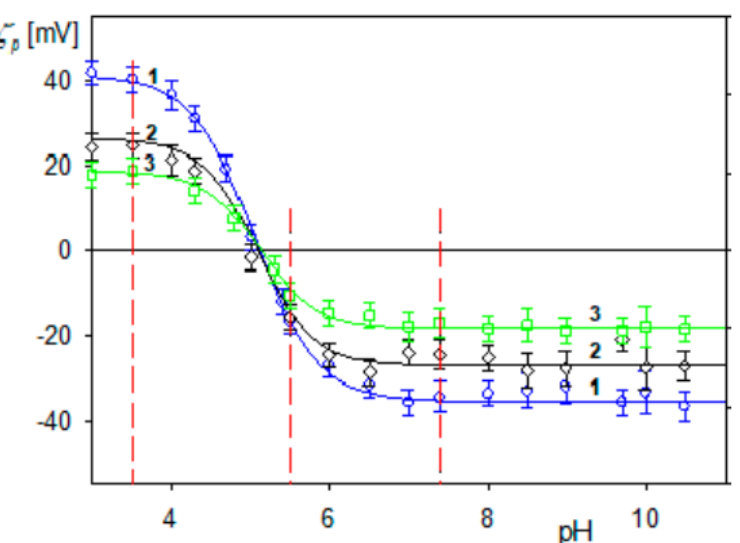
Figure 2. The dependence of the zeta potential of HSA molecules on pH calculated from Equation (3) using the experimental values of the electrophoretic mobility µ e : (1) ( (3). ( (cid:3) ) 0.15 M. The solid lines are the fits of experimental data and the vertical dashed lines denote